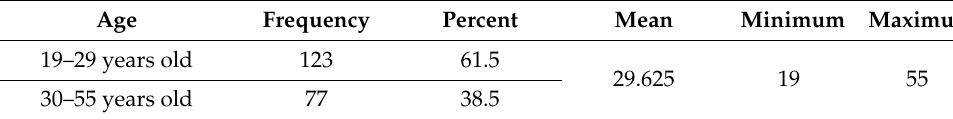
Table 2. Descriptive statistics and frequency for the respondents’ age.